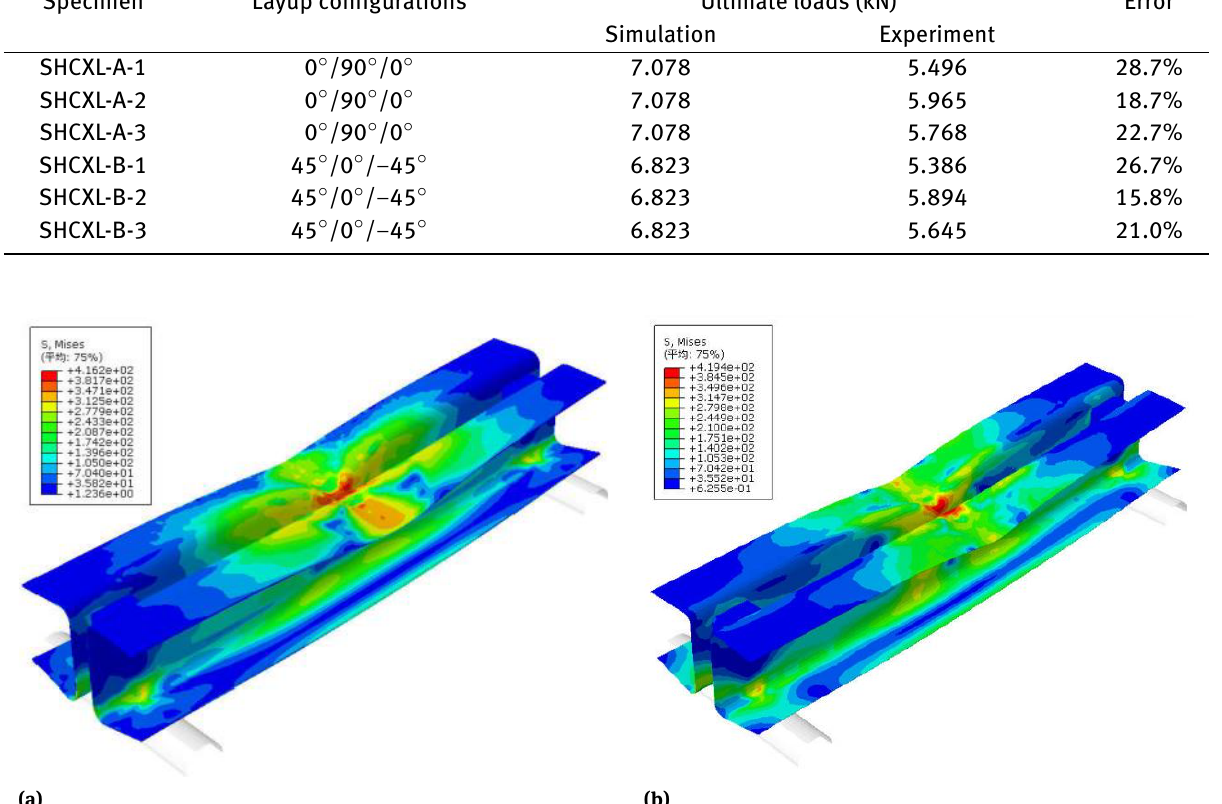
Figure 9: Numerical results of failure modes of double-channel CARALL beams: (a) SHCXL-A and (b)